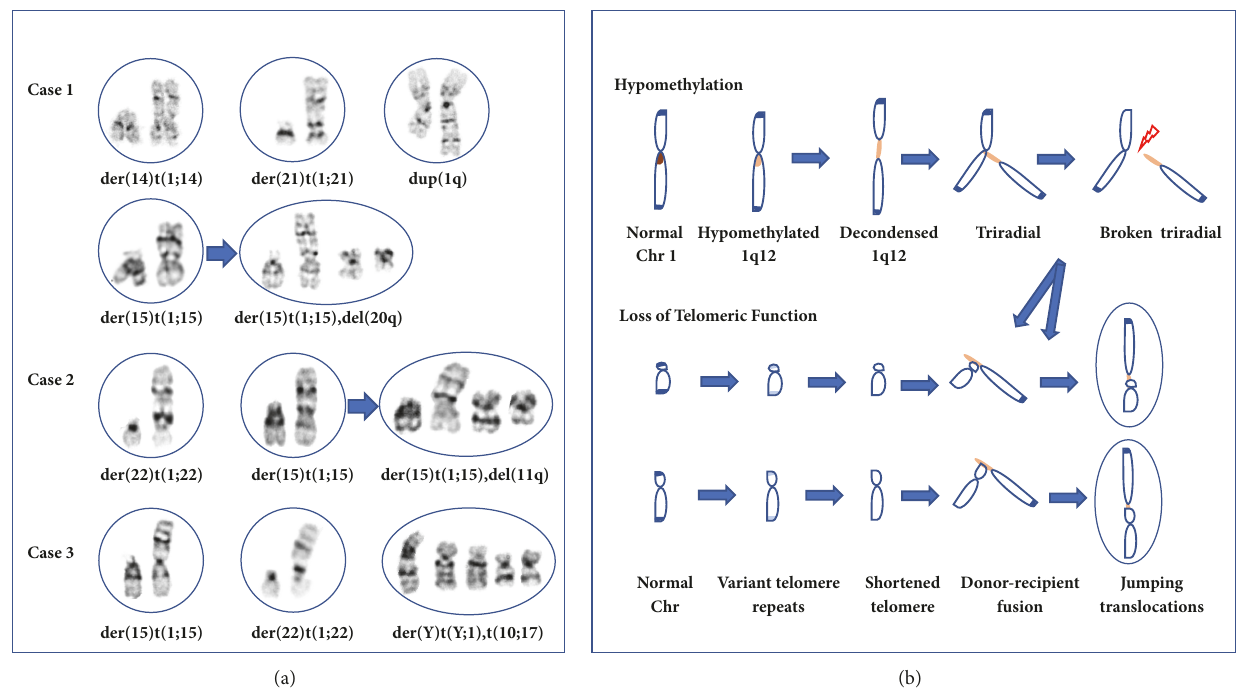
Figure1:(a)Jumpingtranslocationsof1qobservedinthethreepatients.Thejumpingtranslocationineachcelllineageisshowninsideacircle. Arrow points to an additional rearrangement evolved in a cell lineage. (b) Epigenetic alterations in the formation of jumping translocations of 1q. Hypomethylation of 1q12 pericentric heterochromatininduced chromatin decondensation, triradial formation, and break-off of 1q donor segment. Loss of telomeric function by variant telomeric repeats and shortened telomeres produced instable recipient chromosomes. The successive fusions between break-off donor segment and recipient chromosomes resulted in clonal abnormalities with cell linages sharing gains of donor chromosome segment.